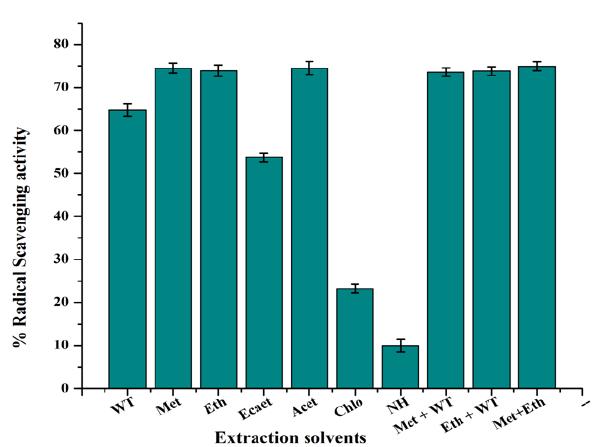
FIGURE 6 - Percent free radical scavenging activity of different solvent extracts of E. intermedia.